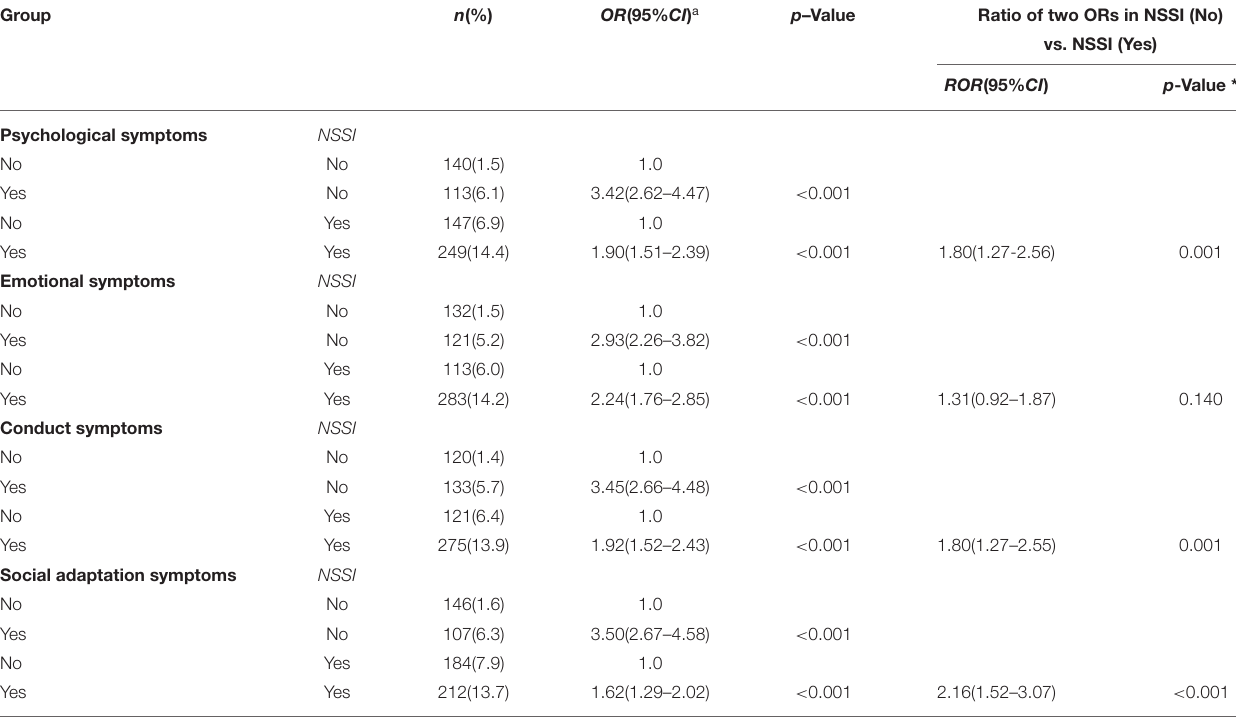
TABLE 2 | Number, % and adjusted OR of SA by psychological symptoms and NSSI. Group n (%) OR (95% CI )